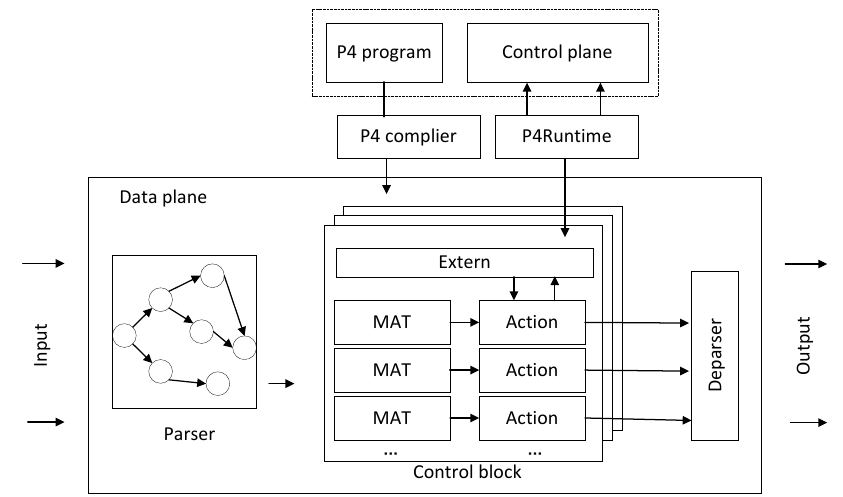
Figure 2. The packet processing pipeline and core concepts of P4.